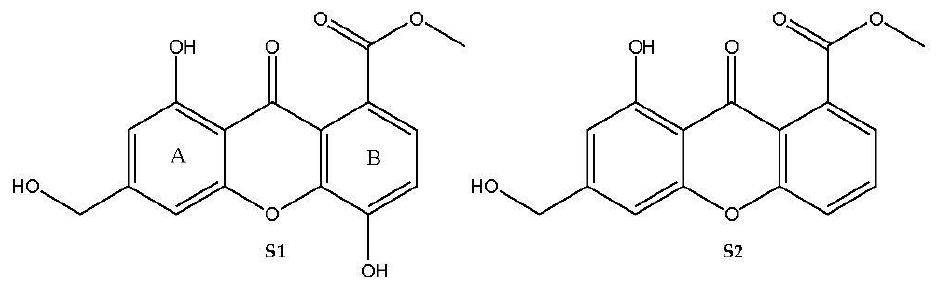
Figure 3. Compounds isolated from Guignardia mangiferae Sydowinol (S1) and Sydowinin A (S2).